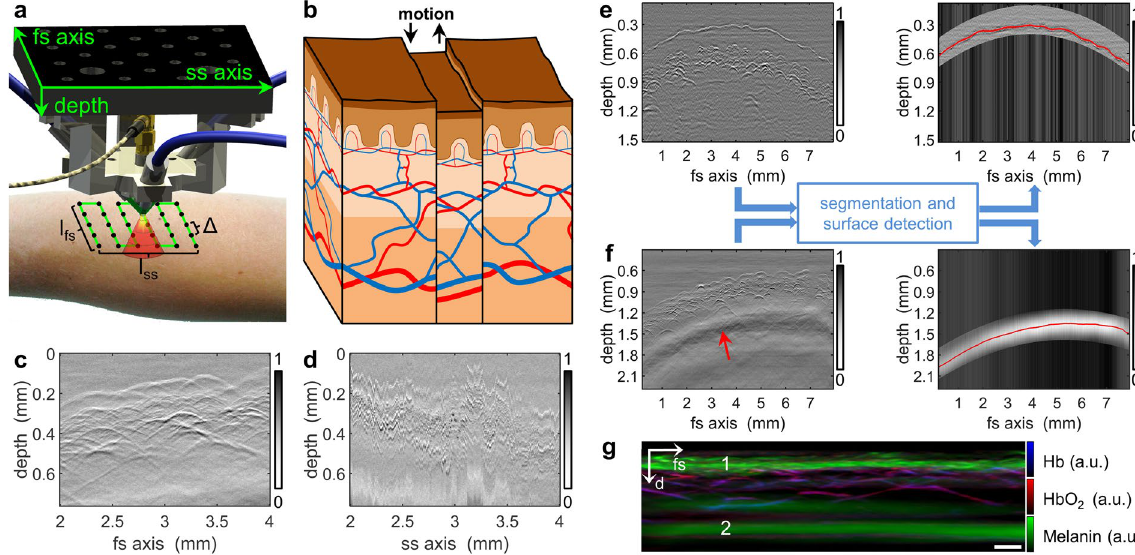
Figure 1. Principle of the proposed motion correction algorithm for RSOM. (a ) Schematic of the detector- illumination unit, which is raster-scanned over the region of interest at a step size of Δ to give final dimensions l fs × l ss . The detector features a cone-shaped sensitivity field (red/yellow). (b) Schematic illustrating how movement (black arrows) during RSOM scanning causes discontinuities in the surface of the epidermal layer as well as disruption of vessels. (c) B-scan of healthy human skin along the fs-axis, showing no discontinuities between subsequent positions. (d) B-scan of the sample in panel c along the ss-axis, showing large motion- induced artifacts. (e) B-scan of healthy human palm (left panel) after segmentation and surface detection were applied (right panel). The stratum corneum is separated clearly from the dermal papillae. ( f ) B-scan of healthy lower arm (left panel) with segmentation and surface detection applied (right panel). Segmentation was performed using only the low-frequency optoacoustic signal 600 µ m below the skin surface (red arrow). The red curve indicates the maximum value of the low-frequency band. (g) Multispectral vertical MAP of healthy lower arm reconstructed without bandpass filtering. The low-frequency signal ( 2 ) shows the spectral signature of melanin and follows the shape of the epidermal layer (1). Scale bar, 250 µ m. Abbreviations: d: depth; fs: fast- scanning; Hb, deoxyhemoglobin; HbO 2 , oxyhemoglobin; ss,